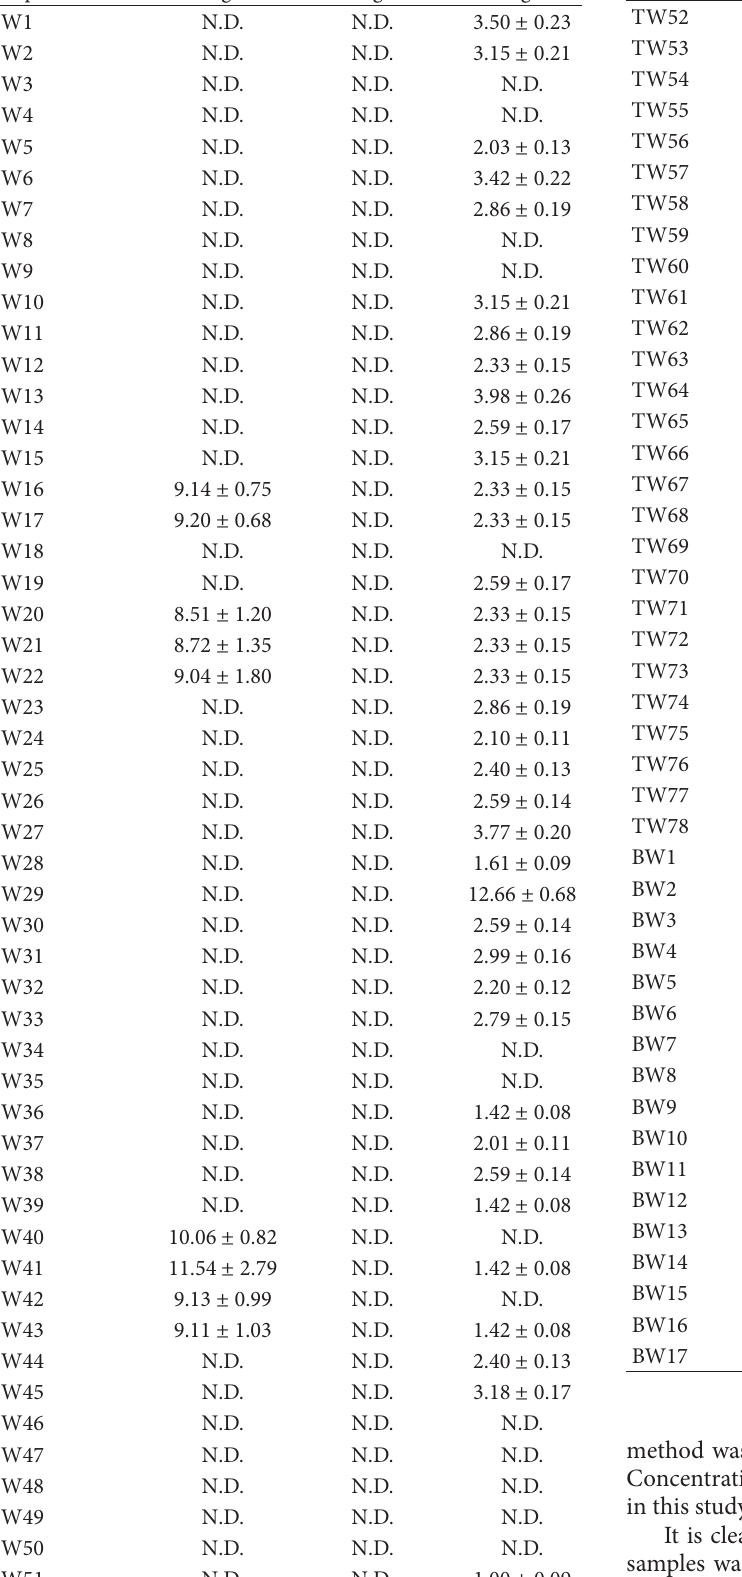
T 5: As, Cd, and Pb results of the samples analyzed. Sample